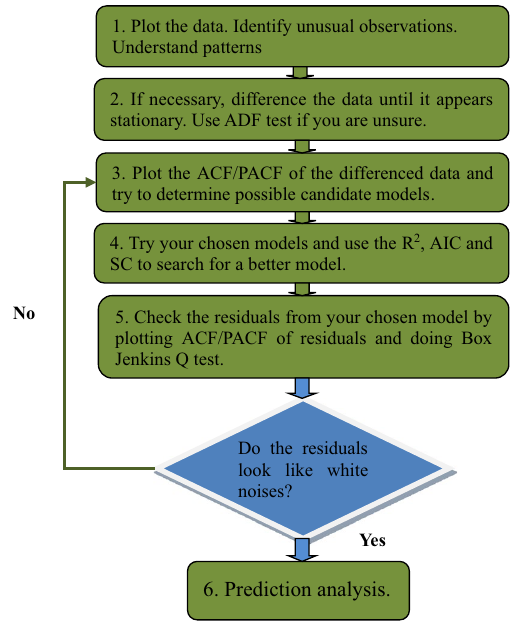
Figure 2. The modeling flowchart of SARIMA